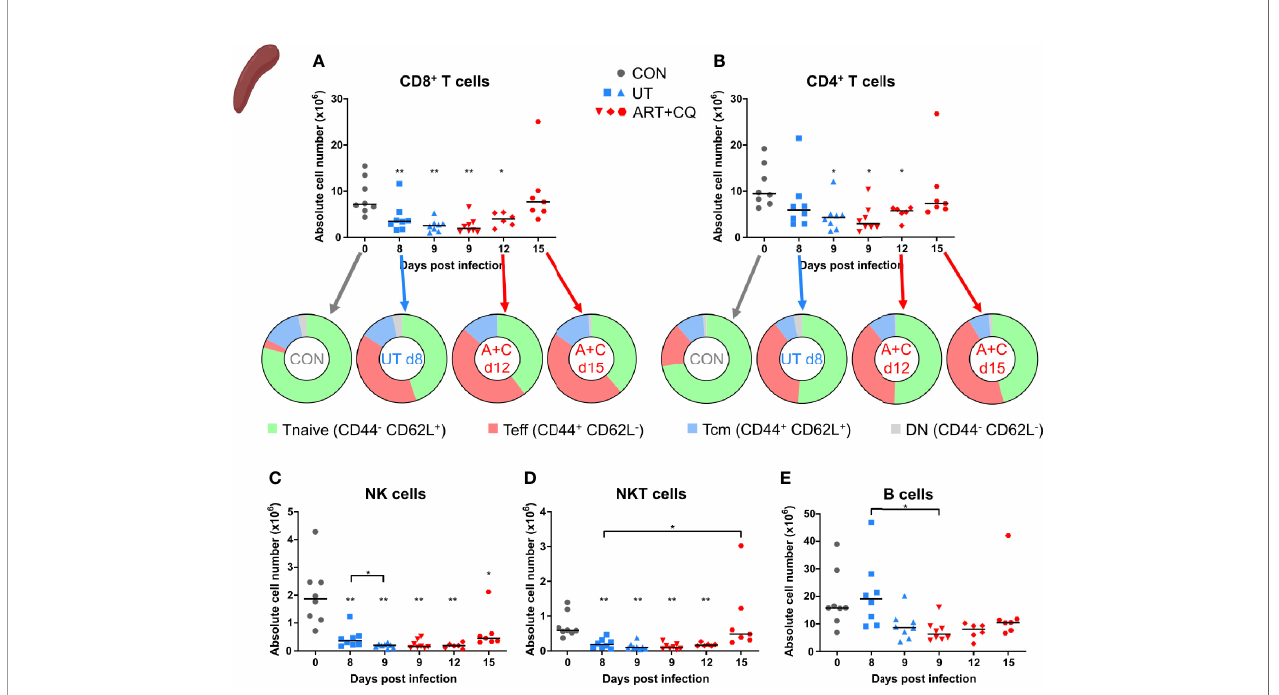
FIGURE 4 | Dynamics of the splenic lymphocyte populations during resolution of malaria-associated acute respiratory distress syndrome (MA-ARDS). C57BL/6 mice were infected with Pb NK65. Mice were injected daily from 8 until 12 days p.i. with 10 mg/kg ART + 30 mg/kg CQ. Mice were dissected at the indicated days p.i. Leukocytes were isolated from the spleen and fl ow cytometry was performed. (A, B) The absolute numbers of CD8 + T cells (CD45 + CD3 + NK1.1 − CD8 + ) and CD4 + T cells (CD45 + CD3 + NK1.1 − CD4 + ) and the proportions of Tnaive (CD44 − CD62L + ), Teff (CD44 + CD62L − ), and Tcm (CD44 + CD62L + ) of the total cell population are shown. Percentages of these subsets are shown in Supplementary Figure 5 . (C – E) The absolute numbers of NK cells (CD45 + CD3 − NK1.1 + ), NKT cells (CD45 + CD3 + NK1.1 + ), and B cells (CD45 + CD3 − NK1.1 − B220 + ) were calculated. Compilation of two experiments. Each symbol represents data of an individual mouse. n=8 for CON on day 0, UT at 8 and 9 days p.i and ART+CQ at 9 days p.i., n=6 for ART+CQ at 12 days p.i., n=7 for ART+CQ at 15 days